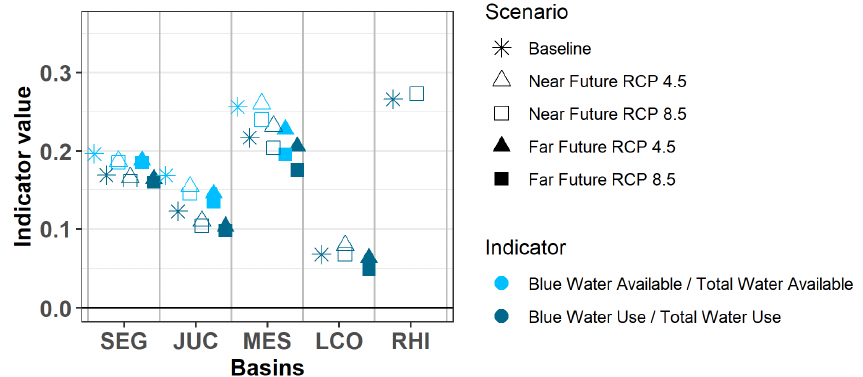
Figure 4. Blue water dependency indicators: (1) Blue water available versus total water available, and (2) blue water use versus total water use for the five river basins under the baseline and climate change scenarios.